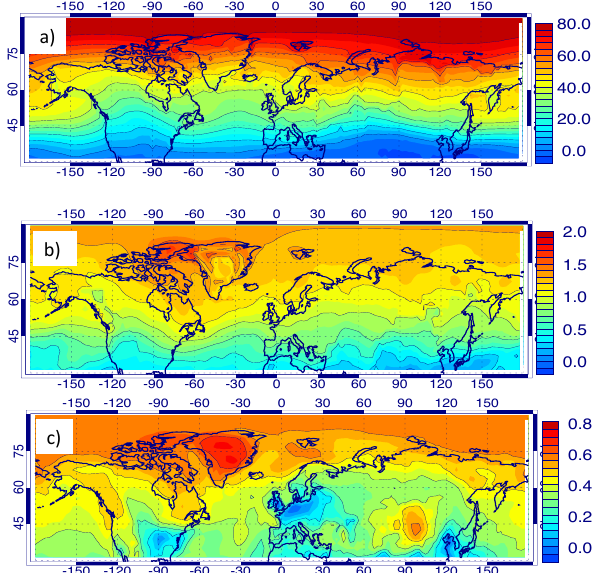
Figure 11. Normalized first EOF component of detrended ozone at (a) 150hPa, (b) 500hPa and (c) the surface. Shown is the average for all four ensembles of the EOF multiplied by the standard devi- ation of the principal component. The absolute value of the result shows the variability of ozone (ppb) expected due to variations in the first EOF component; the sign of the result shows the relation between variability at different